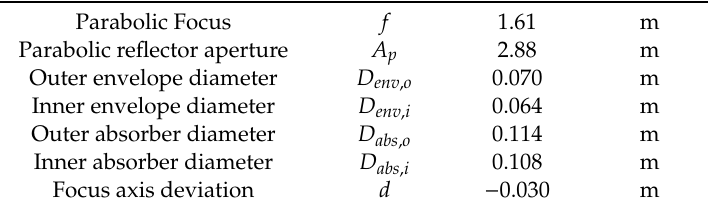
Table 1. Geometrical data of the Heat Collector Element (HCE)